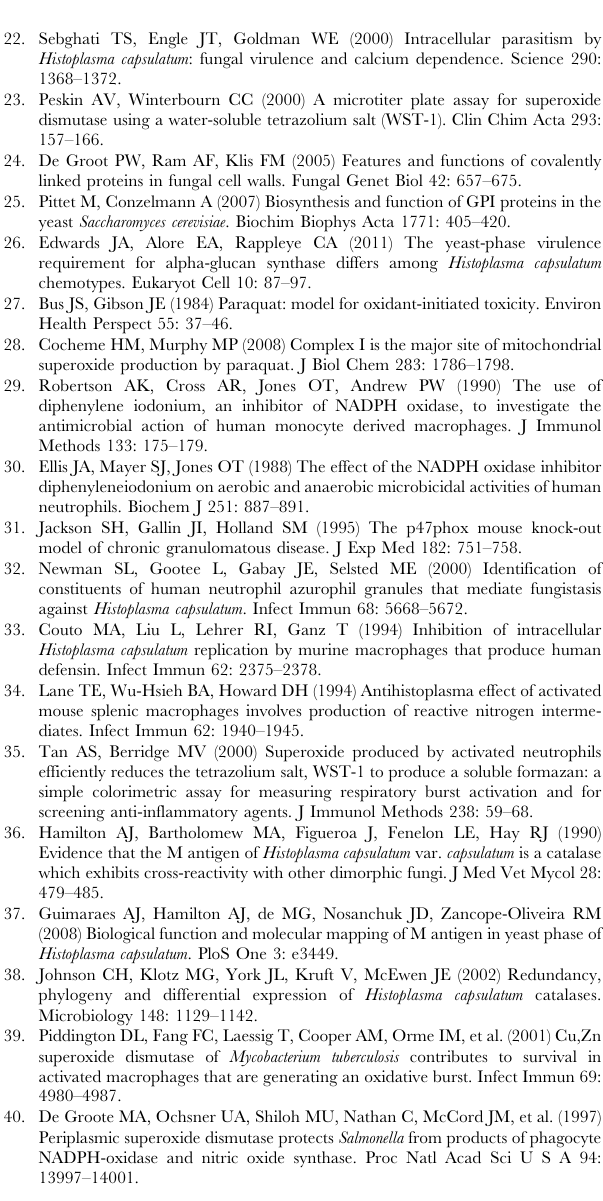
Figure S4 Intracellular Sod1 function is dispensable for Histoplasma virulence. Kinetics of sublethal lung infection with Histoplasma yeasts. Wild-type C57BL/6 mice were intrana- sally infected with approximately 2 6 10 4 gfp -RNAi (OSU104) or gfp:SOD1 -RNAi (OSU105) Histoplasma yeasts. The fungal burden in lungs was determined by quantitative platings for Histoplasma cfu at the indicated times representing progressing infection. Each data point represents cfu counts per lung from an individual animal (n= 4 per time point) and horizontal bars represent